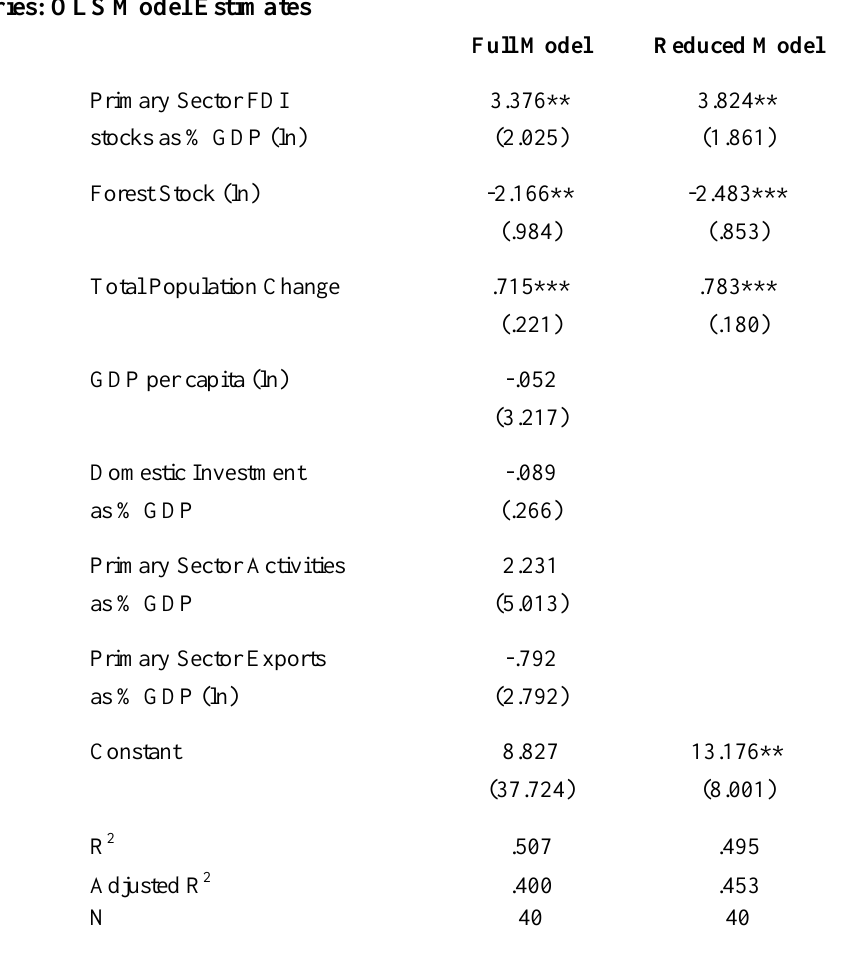
Table 3. Unstandardized Coefficients for the Regression of Deforestation on Primary Sector Foreign Investment and other Selected Independent Variables in Less-Developed Countries: OLS Model